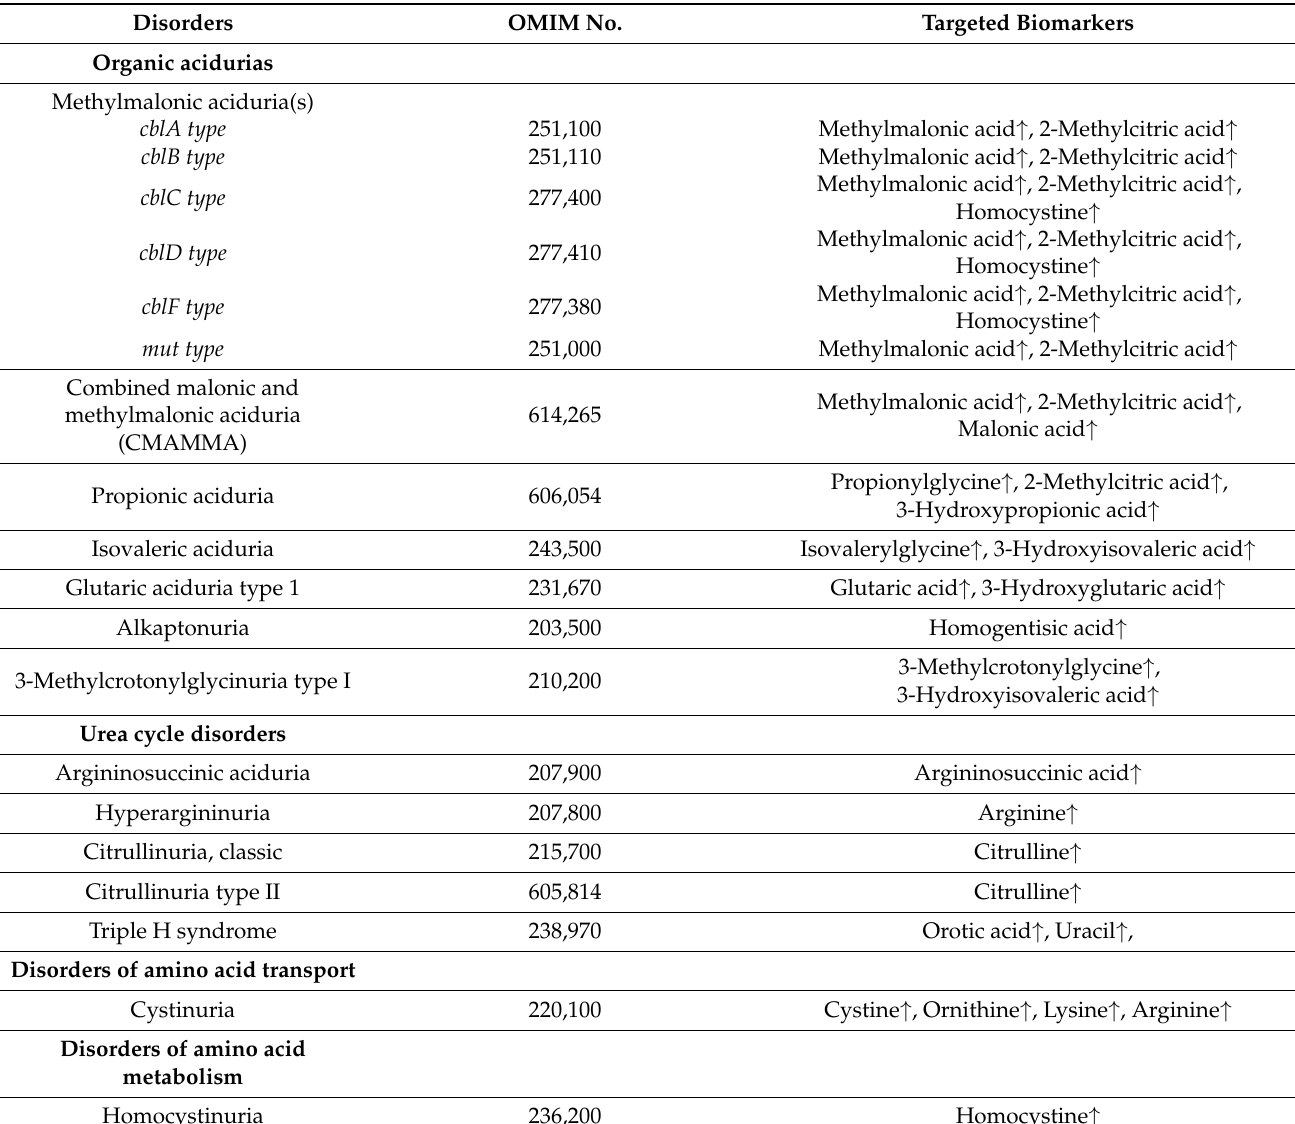
Table 1. Targeted inborn errors of metabolism and associated biomarkers. OMIM